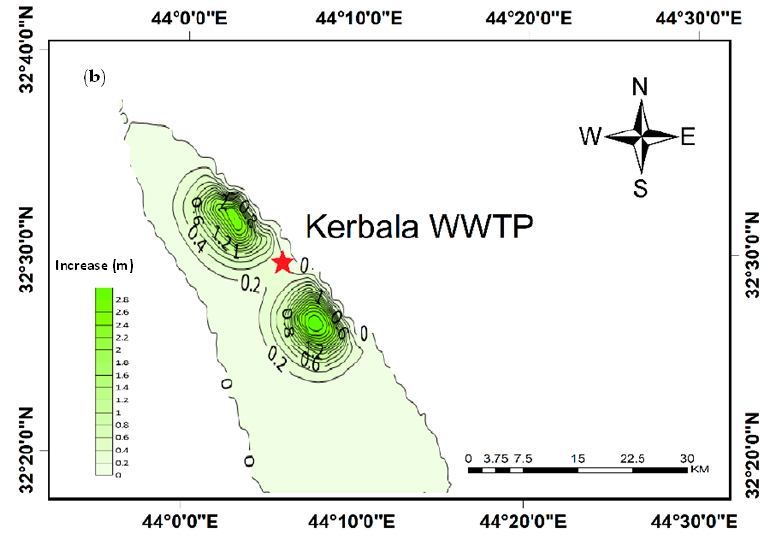
Figure 10. Effect of artificial recharge in 2030: differences in groundwater elevation increases ( a ) between MOD2 and MOD1 and ( b ) between MOD3 and MOD1.